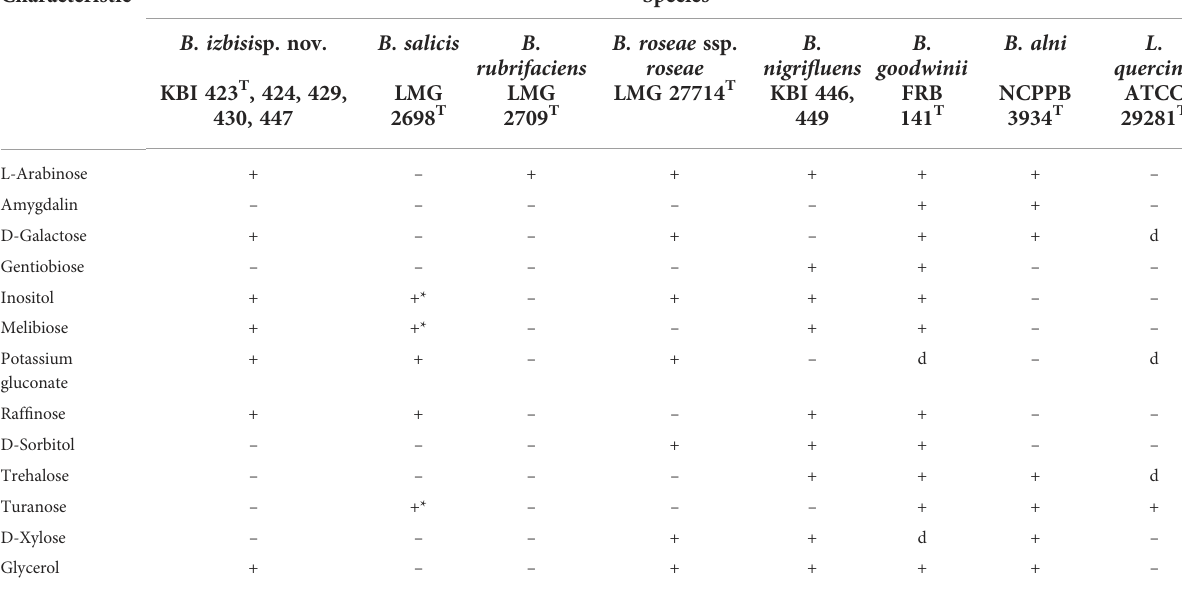
TABLE 2 Differential phenotypic characteristics for B. izbisi and other Brenneria and Lonsdalea species.